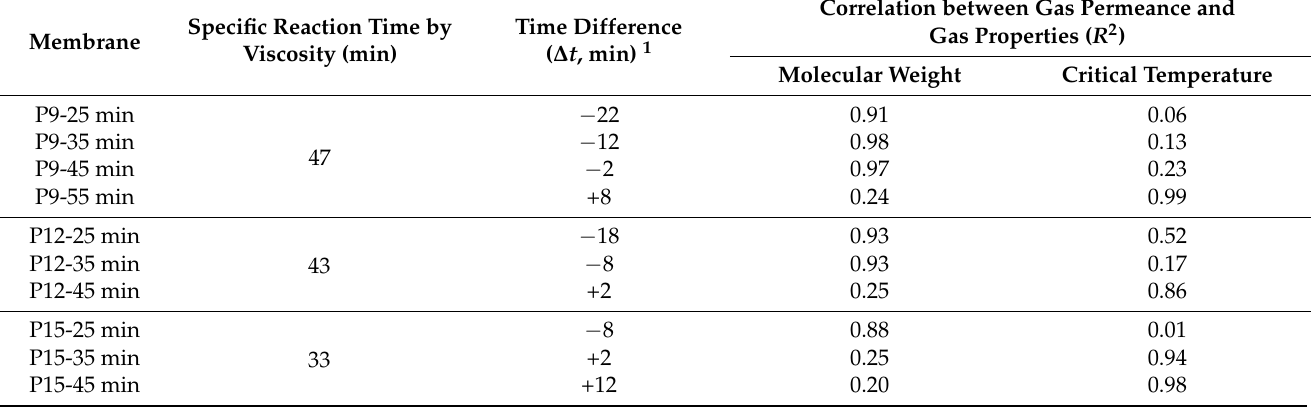
Table 1. Reaction times of the membrane preparation and the correlation of permeance with molecular weight and critical temperature for the hybrid PDMS membranes.